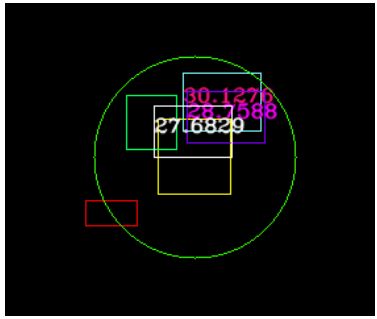
Figure 17. The result of the UKF and neural fusion depicted in white and purple.